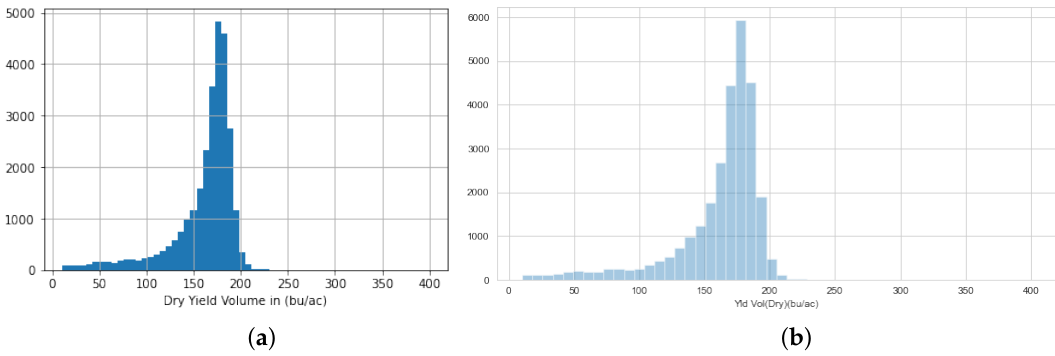
Figure 1. ( a ) Histogram for Yield Vol (Dry). ( b ) Distribution plot for Yield Vol (Dry).